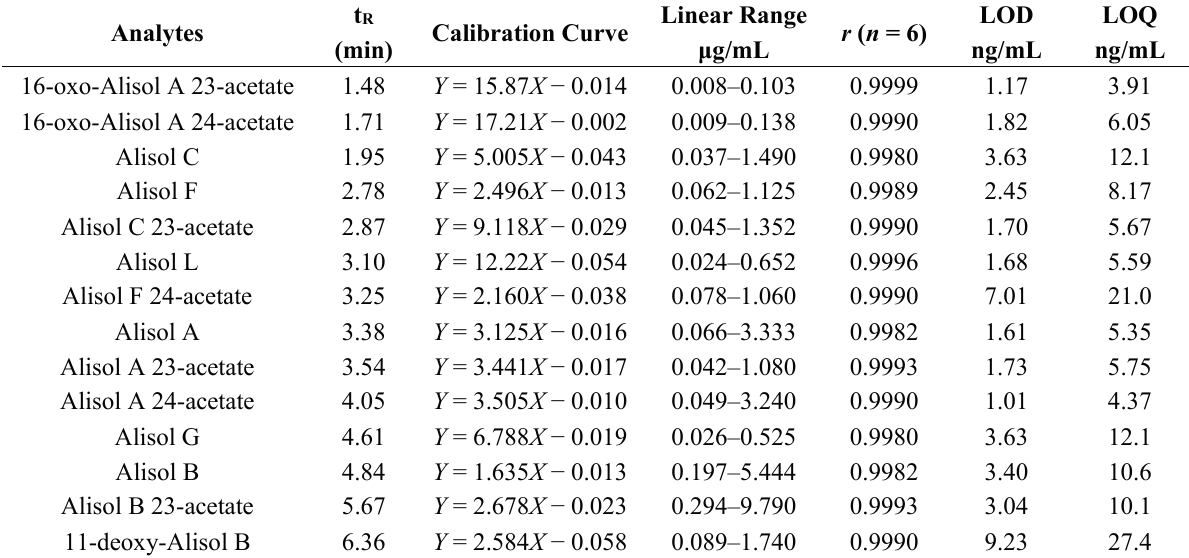
Table 3. Retention time, linear regression data, LODs and LOQs of fourteen analytes for UPLC-QqQ MS